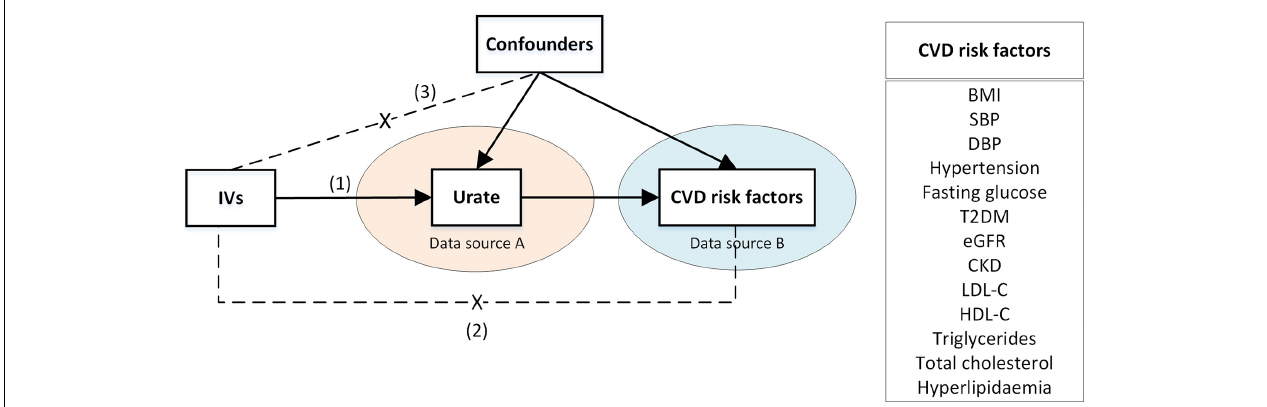
FIGURE 1 | A two-sample Mendelian Randomization causal diagram with three instrumental variable assumptions. (1) IVs are associated with urate; (2) IVs have no direct effect on the CVD risk factors, except through urate; (3) IVs are not associated with confounders of urate -CVD risk factor association. Arrows represent associations. Dashed lines with a cross in the middle represent no associations. BMI, body mass index; CKD, chronic kidney disease; CVD, cardiovascular disease; DBP, diastolic blood pressure; eGFR, estimated glomerular filtration rate; HDL-C, high-density lipoprotein cholesterol; IV, instrumental variable; LDL-C, low-density lipoprotein cholesterol; SBP, systolic blood pressure; T2DM, type 2 diabetes